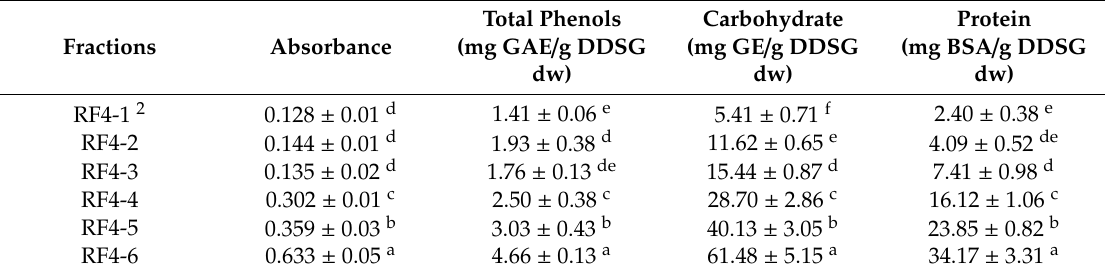
Table 7. Absorbance, total phenolic, carbohydrate, and protein content of di ff erent MW fractions 1 .